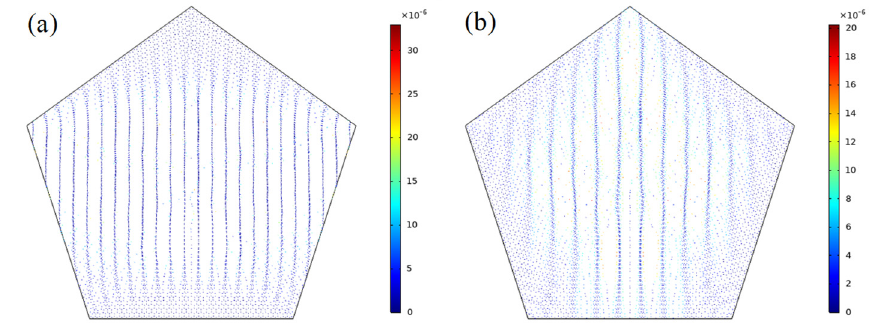
Figure 7. Comparison between particle manipulations in two modes: ( a ) IEM mode and ( b ) AEM mode.